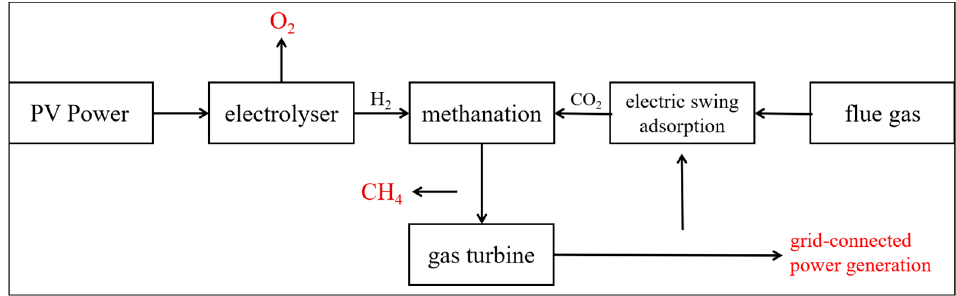
Figure 4. Photovoltaic power generation—gas preparation—gas power generation technology pro- cess diagram.